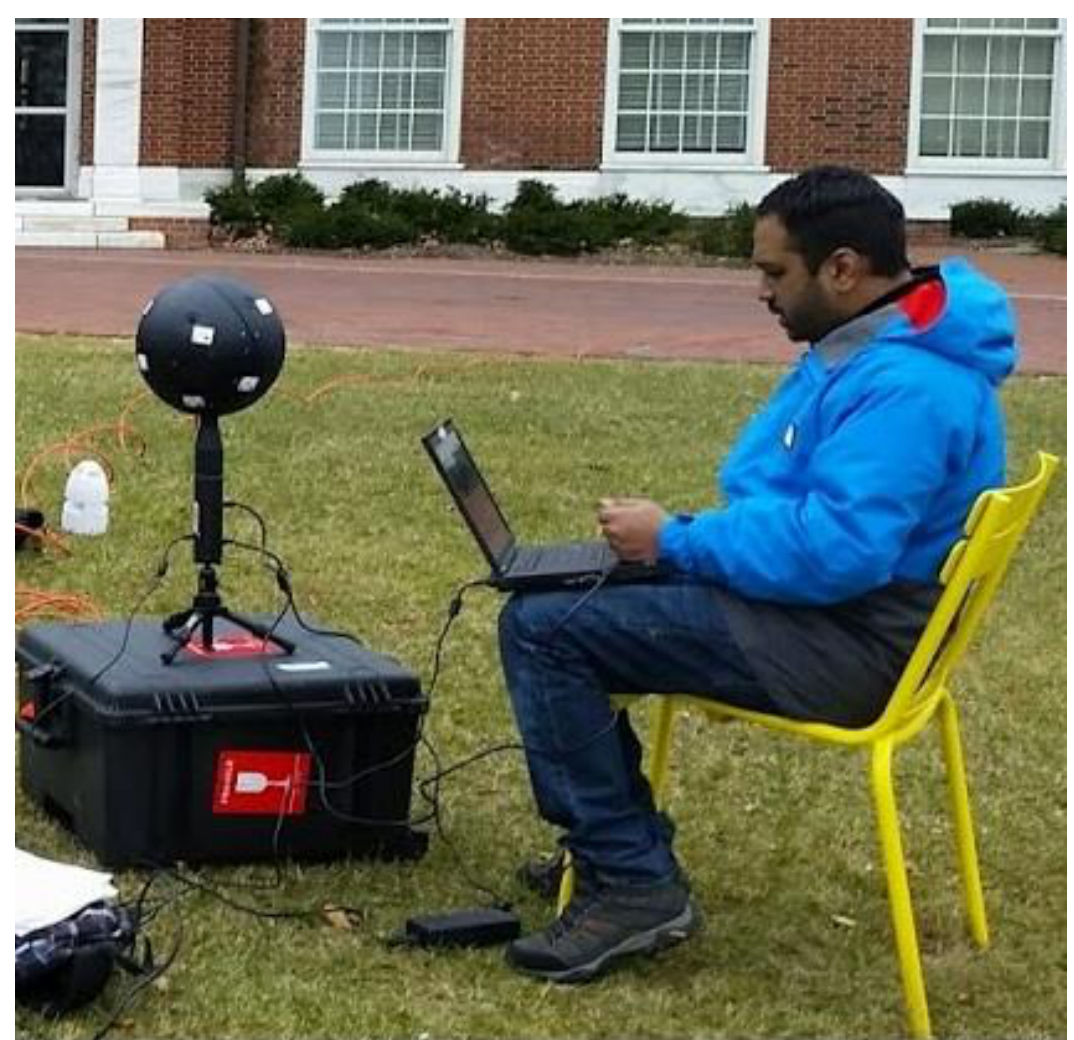
Figure 5. The audiovisual camera used to collect data in a recording session